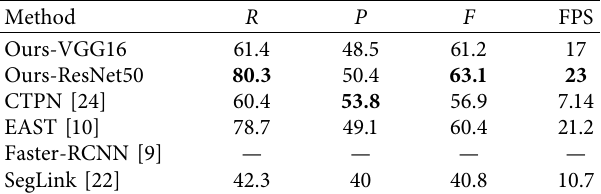
Table 3: Results on the CTW1500